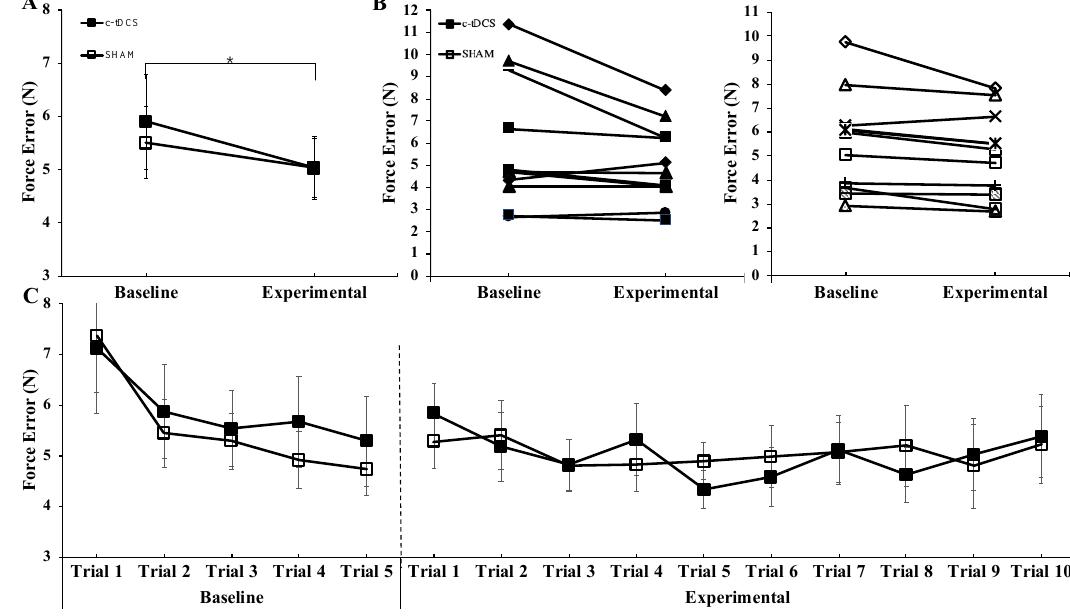
Figure 3. Force error in the precision grip task (PGT) for the cerebellar transcranial direct current stimulation (c-tDCS) (closed squares) and SHAM groups (open squares) in the Baseline and Experimental conditions. ( A ) The force error was not significantly different between the c-tDCS and SHAM groups ( p = 0.861), but it was significantly lower in the Experimental condition compared to the Baseline condition ( p = 0.005). * indicates a significant difference between the Baseline and Experimental conditions. ( B ) Individual PGT participant data corresponding to the data in Panel (A) for the 11 participants in the c-tDCS group and 11 participants in the SHAM group. ( C ) For illustrative purposes, the individual PGT trials corresponding to the average data presented in Panel (A) are depicted. It can be seen that there is no trend for PGT performance to improve with trial number to a greater extent in the c-tDCS group compared with the SHAM group due to the accumulating stimulation time.